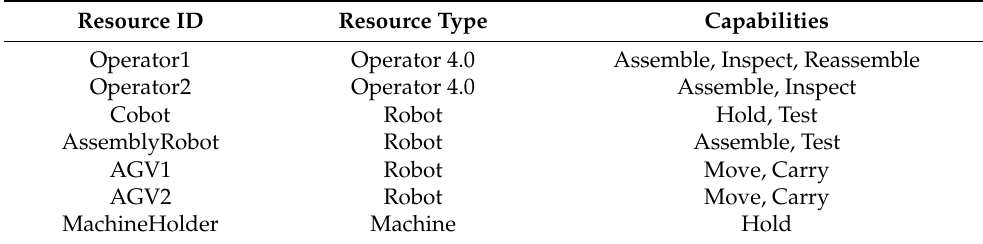
Table 1. Shop floor